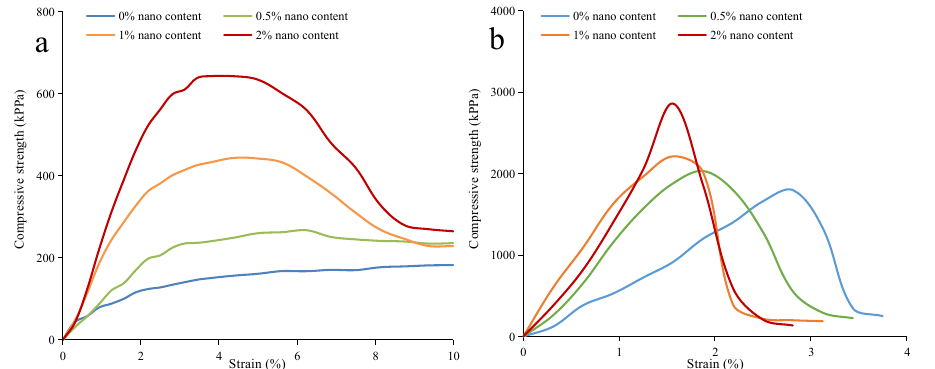
Figure 10. The unconfined compressive strength of nano-SiO 2 -reinforced clayey soil ( a ) under uncured conditions ( b ) under cured conditions.